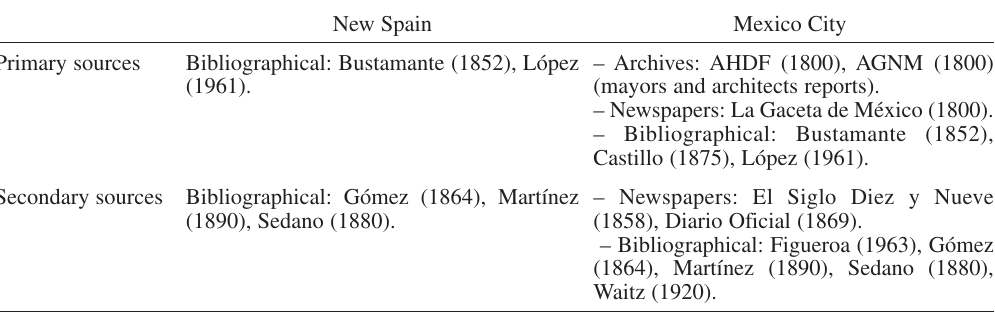
Table II. Sources for the 1800